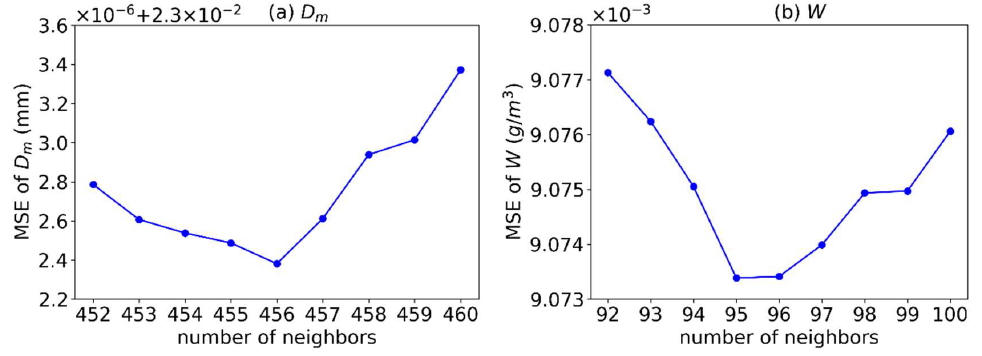
Figure 8. The mean square errors of ( a ) D m and ( b ) W, associated with the model complexity. Note the abscissa of ( a ) is the number of neighbors used in the nearest neighborhood model for 𝜇 and in ( b ) is the complexity of the model for D max .